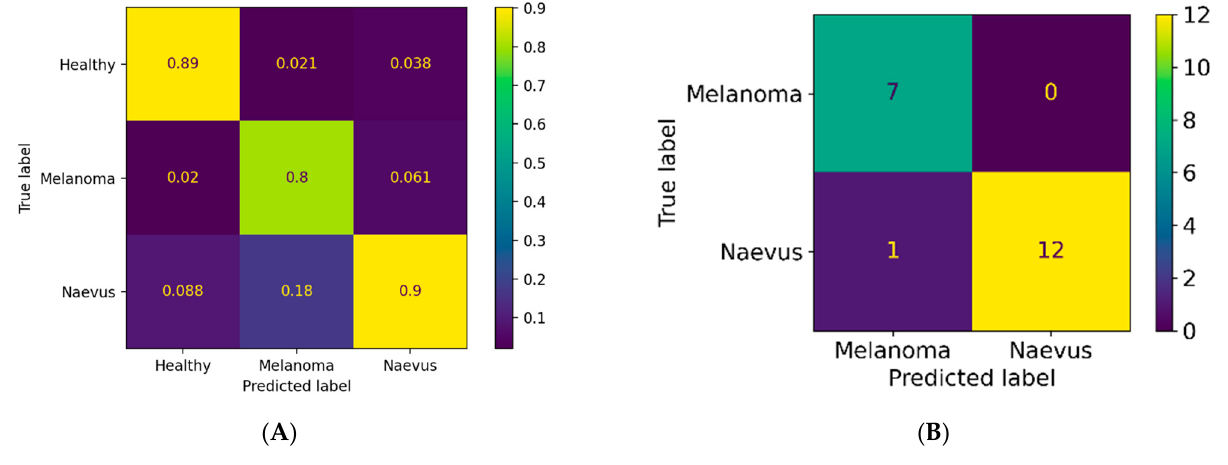
Figure 6. Confusion matrices presenting positive prediction values (PPVs) for pigmented lesions in pixel-wise ( A ) and majority voting analyses ( B ). Melanoma = malignant melanoma, naevus = pigmented nevus.